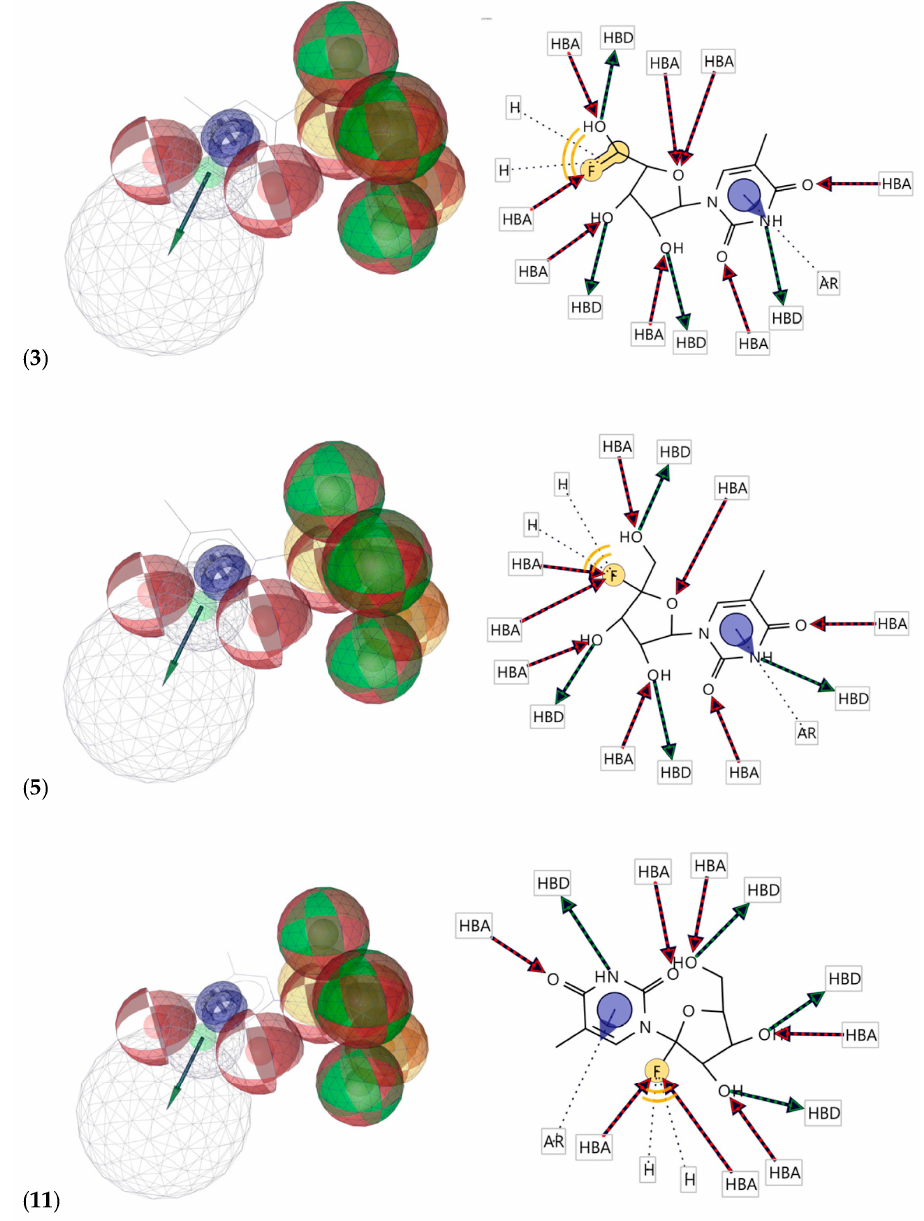
Figure 5. The 2D and 3D pharmacophoric features of structures ( 3 ), ( 5 ), and ( 11 ). Red, HBAs; green, HBDs; purple, AR; yellow, H.